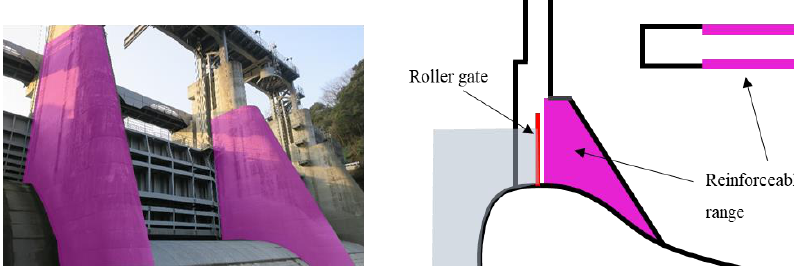
Figure 19. Roller gate and reinforceable range.